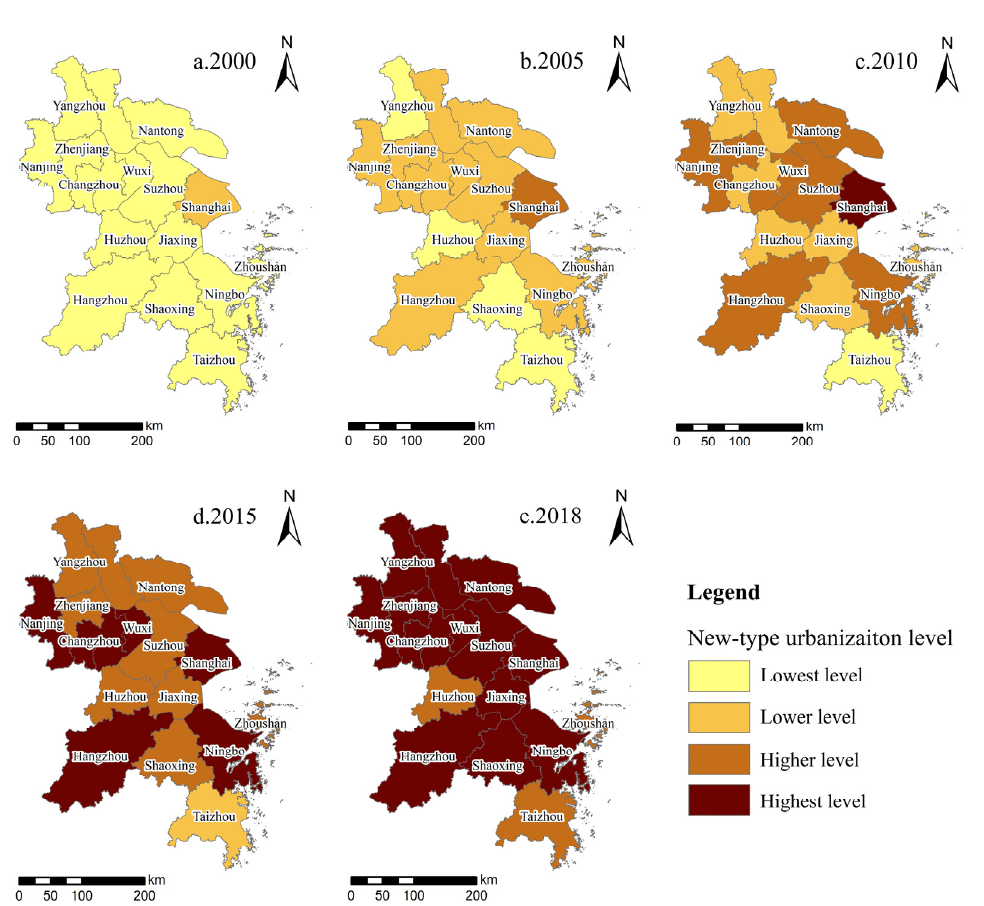
Figure 5. The spatial pattern of new-type urbanization levels of the Yangtze River Delta during 2000–2018.